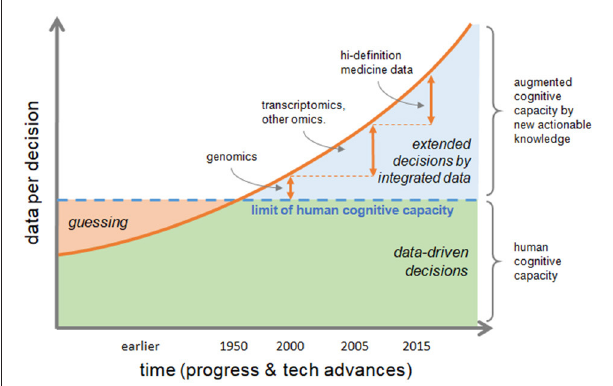
FIGURE 1 | Transformation of decision making process. The increasing speed of data production and their volume and variety, are challenging human cognitive capacity. Educated guessing as the process of inference when information is not at hand was quite the norm in the past; today the bottleneck of human ability to process information can be bypassed if data are correctly integrated to produce new actionable knowledge, thus augmenting human cognitive capacity. Decisions by phenotype, which is typical of traditional healthcare, tends to be replaced by data-driven decisions extending the reach of medical actions either by efficacy or by